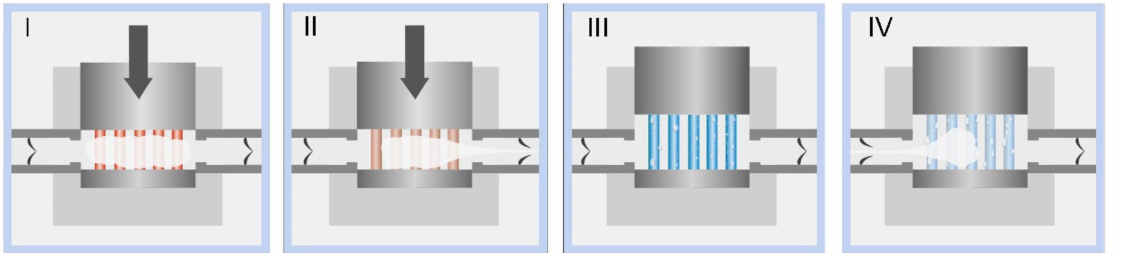
Figure 1. The AEH concept with one segment in four consecutive time steps [19]: (I) A load is applied to the ECM, causing it to heat up. The fluid on the surface evaporates. (II) The pressure in this segment increases, causing the right valve to open and steam to flow into the condenser. (III) When the load is removed from the ECM, it cools down. (IV) The pressure in the chamber decreases to a level below the pressure in the previous segment, causing the left valve to open and steam to flow from the evaporator into the segment and condense on the